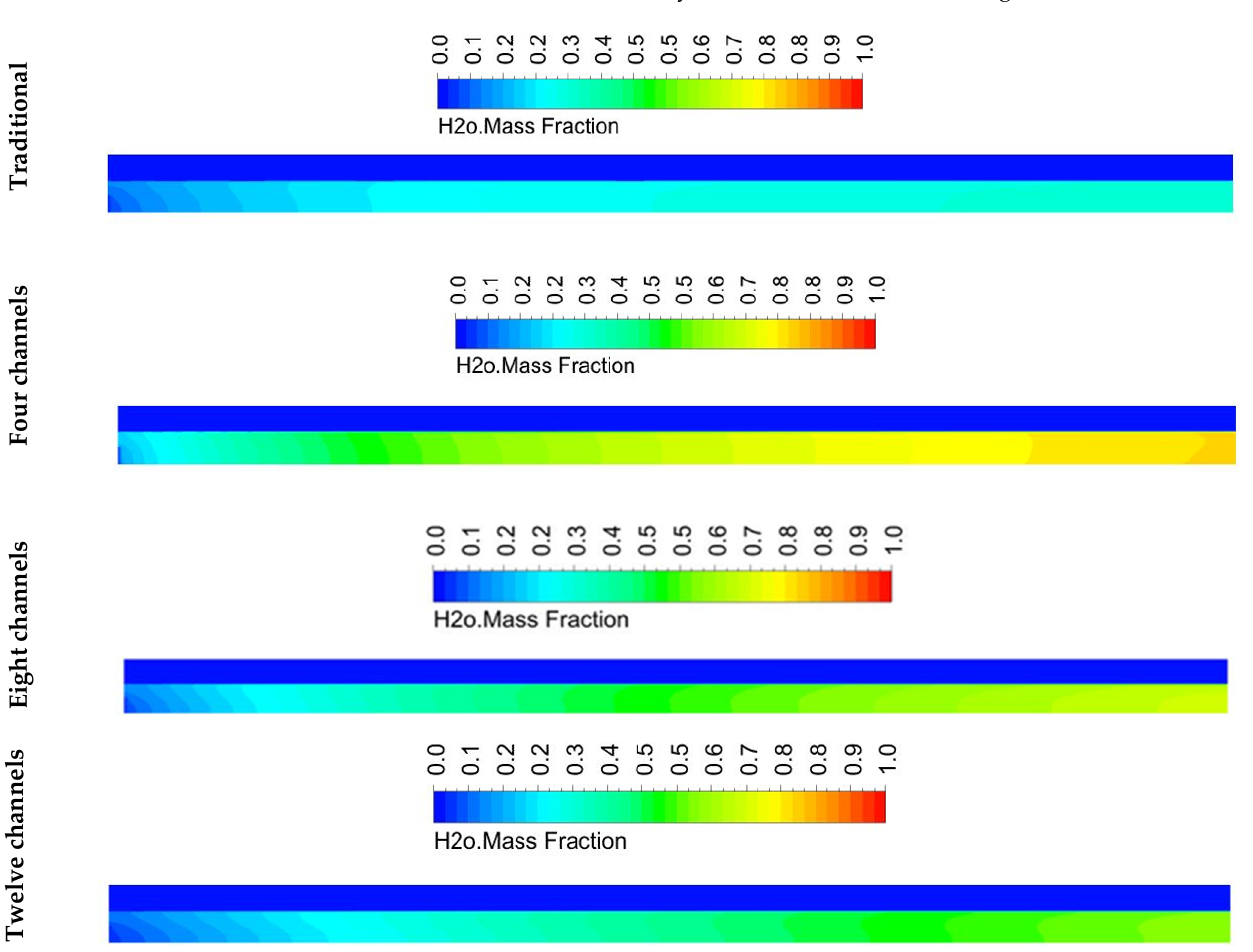
Figure 10. Water vapor concentration contours through the cell for different designs.